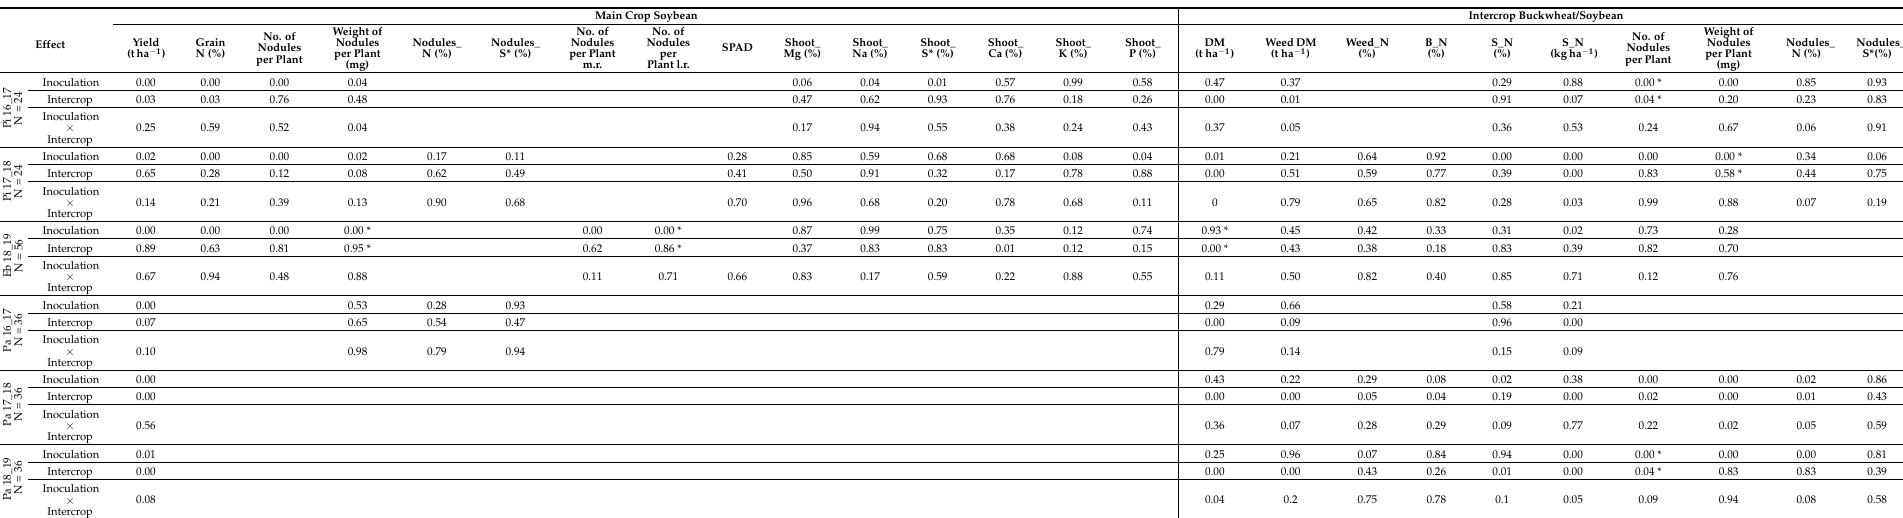
Table A1. Tests of Fixed Effects, p